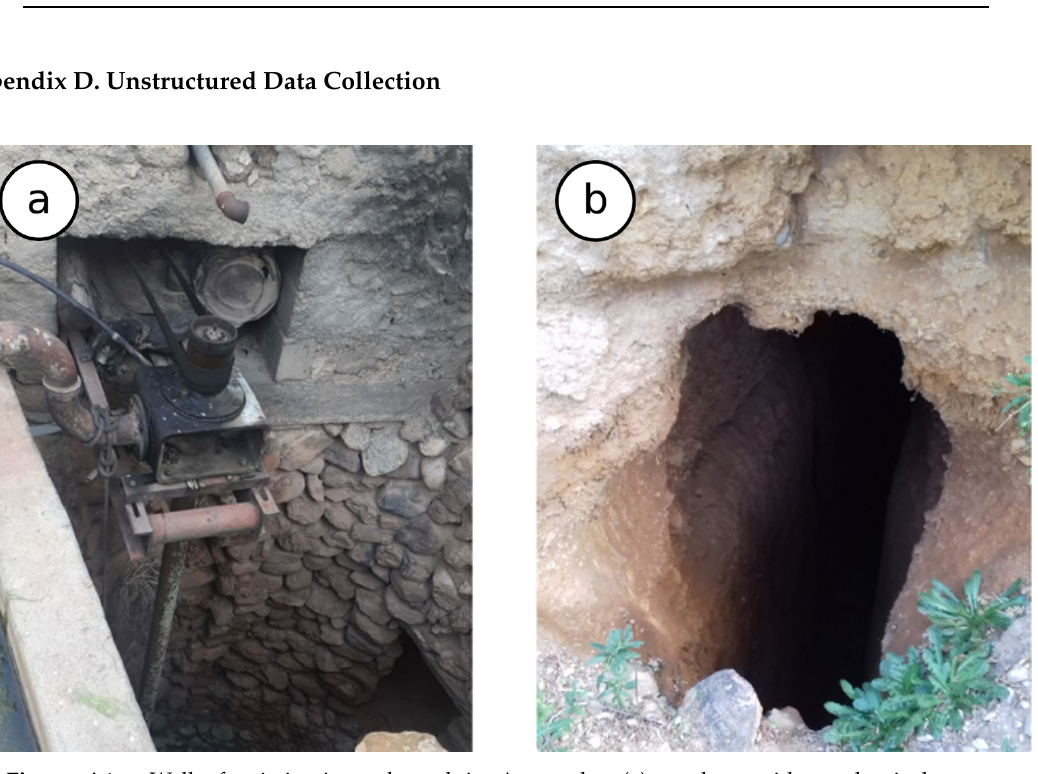
Figure A1. Wells for irrigation adopted in Assaragh: ( a ) modern with mechanical pump, ( b ) and